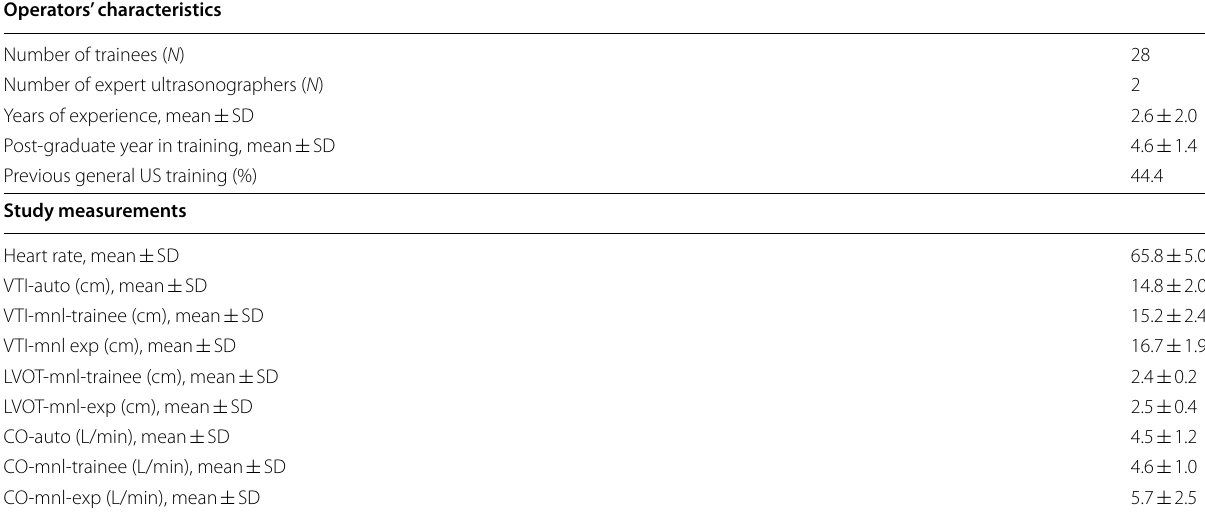
Table 1 Operators’ characteristics and study measurements